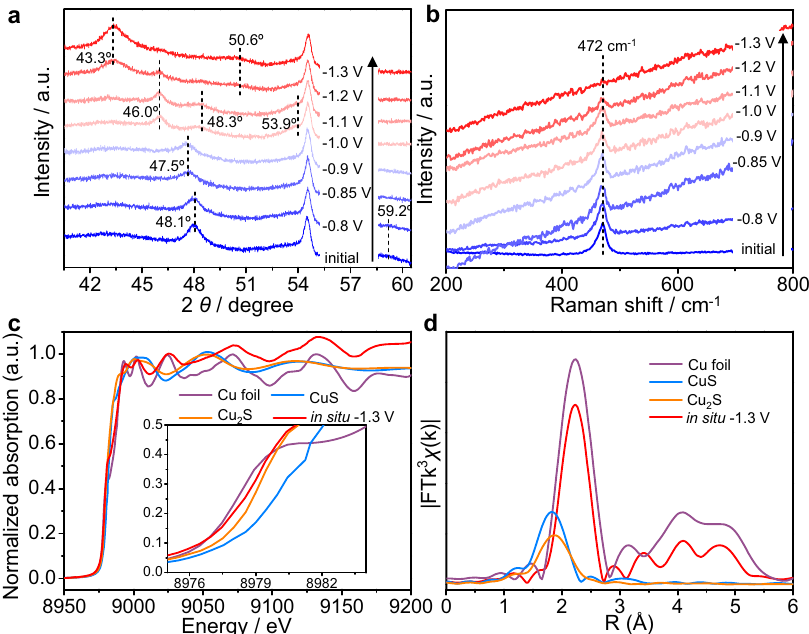
Fig. 3 Electrochemical in situ characterization of converting CuS NAs to Cu-S NSs under cathodic potential. a In situ potential-dependent XRD pattern and b in situ potential-dependent Raman spectra of CuS NAs. c In situ XANES and d EXAFS spectra of CuS NAs at − 1.3 V vs. Hg/HgO. The spectra of Cu foil, CuS, and Cu 2 S were also shown for